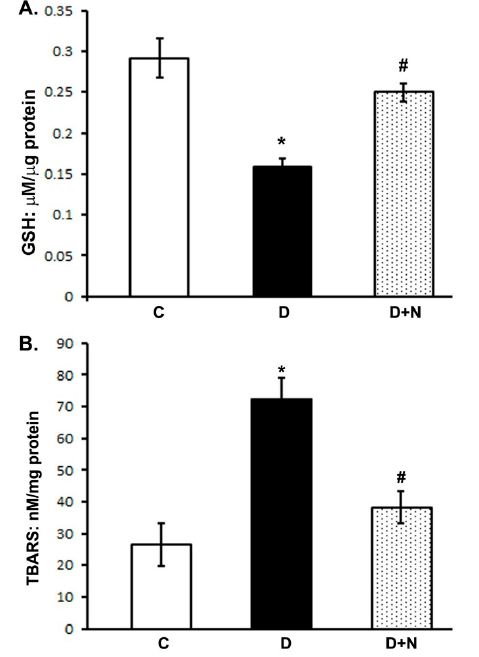
Figure 1. Effects of naringenin on glutathione (GSH) and thiobarbituric acid reactive substances (TBARS) levels in retina of diabetic and non-diabetic animals. (Panel A ) and (panel B ) represents measurements of GSH and TBARS respectively. Values are expressed as means ± SEM (standard error of mean); n = 6/group. D significantly different from control (C) (* p < 0.01); and D + N significantly different from D ( # p < 0.05). C represents control, D as diabetic, and D + N as diabetic rats treated with naringenin.